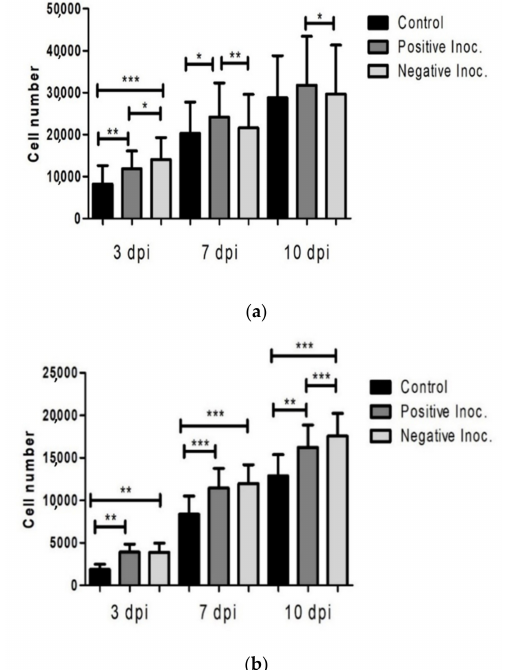
Figure 2. Cell viability study by MTT in infected oBM-MSC cultures in growth conditions ( a ) and neurogenic differentiation ( b ) 3, 7 and 10 days post-inoculation (dpi). oBM-MSCs were from